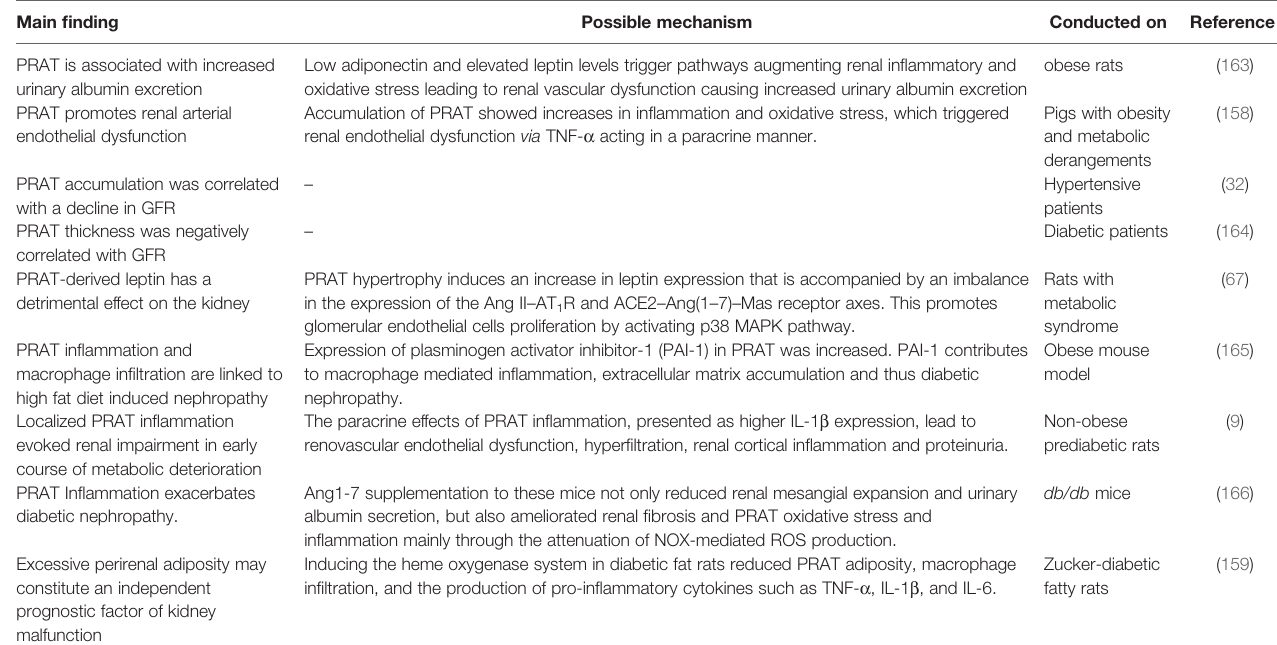
TABLE 1 | Main fi ndings of studies linking perirenal adipose tissue to renal disorders. Main fi